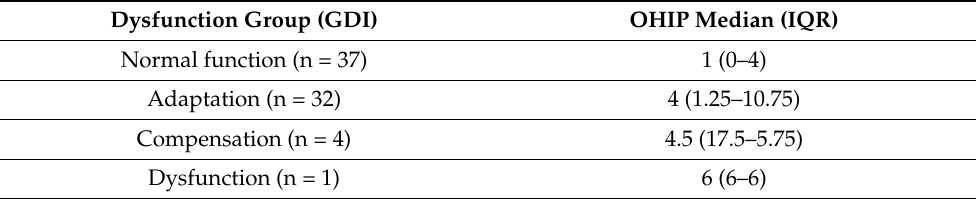
Table 3. Comparison of dysfunction groups (GDI) and OHIP-G14